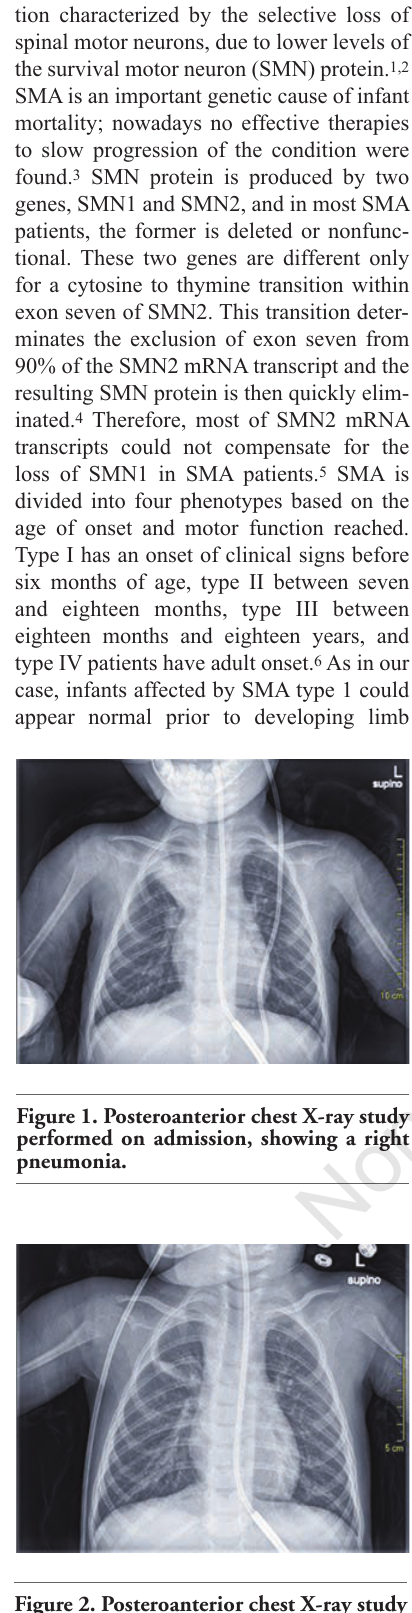
Figure 2. Posteroanterior chest X-ray study returned to normal after Free Aspire treat-